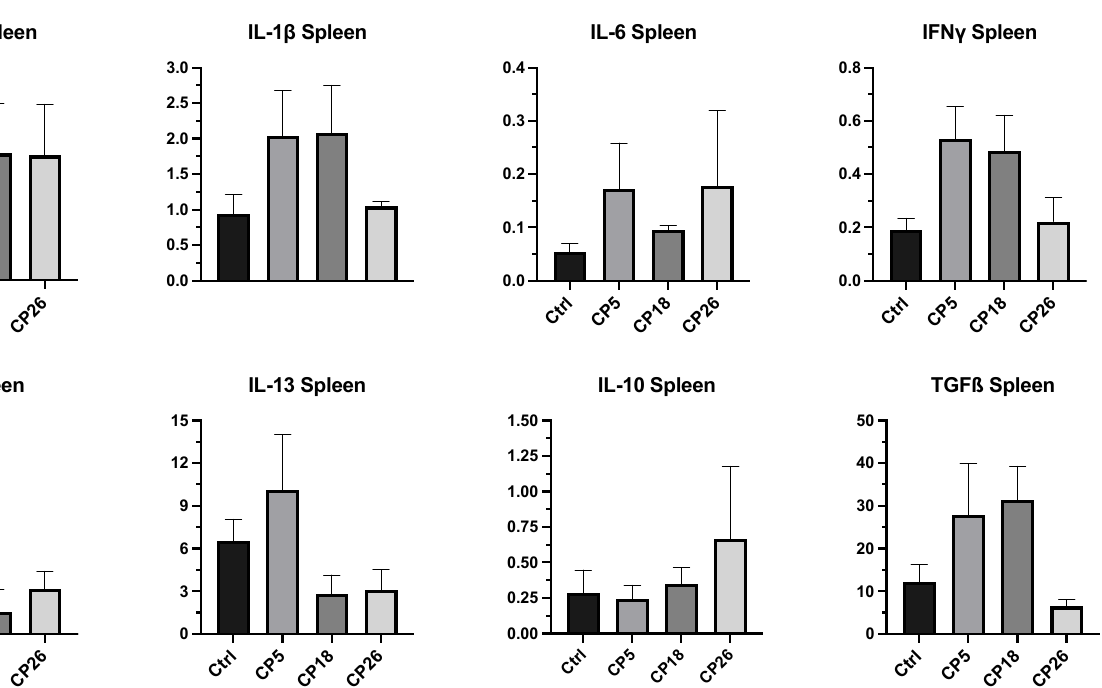
Figure 7 . Effect of C. perfringens on immune gene expression in the spleen of broiler chickens. One-day-old commercial broiler chickens were fed an antibiotic-free diet and challenged with one of three different C. perfringens strains along with the uninfected control via intracloacal inoculation on day 18 of age, administered twice daily for 4 consecutive days, followed by necropsy on day 22. Spleens were collected in RNAlater for RNA extraction and cDNA synthesis. Real-time PCR to quantify the expression of IL-1 β , IL-4, IL-6, IL-10, IL-13, IFN γ , TLR-21, and TGF β genes was performed along with the housekeeping gene ( β -actin). The expression levels are shown as relative to β -actin. Different letters above the standard error of mean bars indicate significant differences ( p < 0.05) between the groups. Ctrl—Control (uninfected); CP— C. perfringens strain.